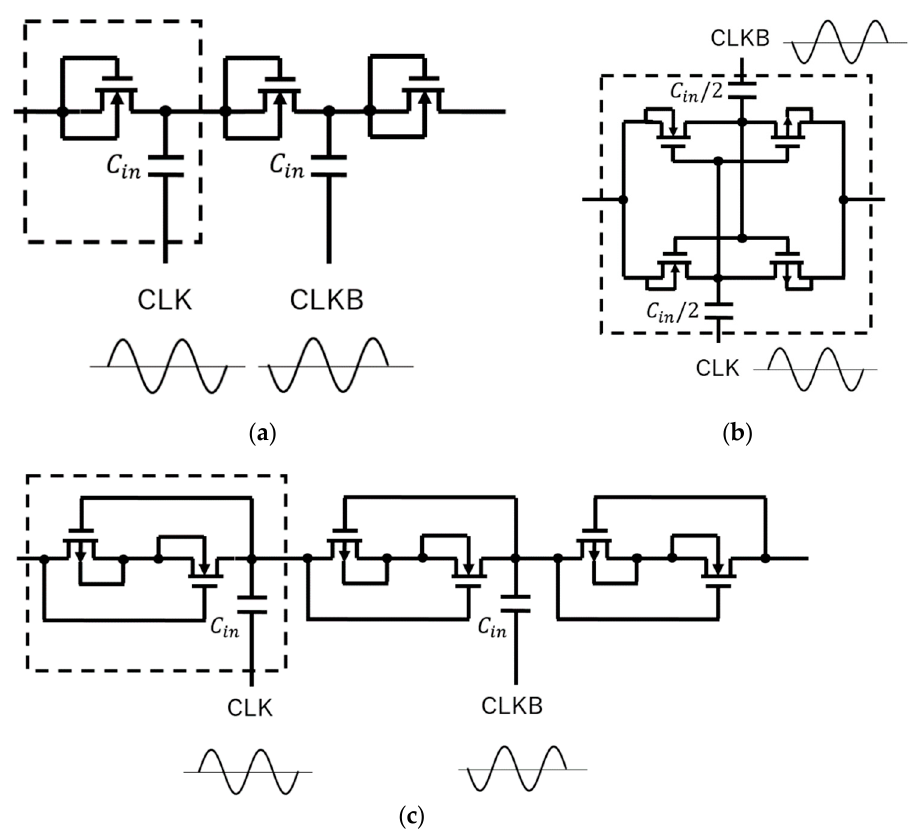
Figure 2. Schematics of ( a ) a single-diode rectifier, ( b ) a CMOS latch-type rectifier, and ( c ) an ultra- low-power diode (ULPD).